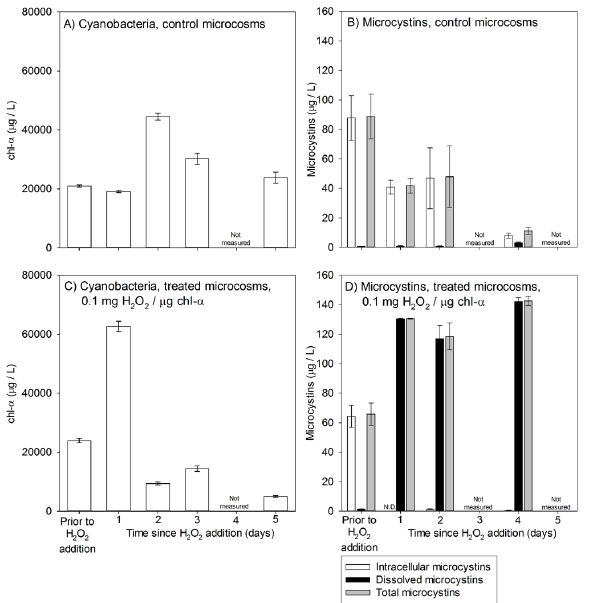
Fig. 1. Results from the first laboratory trial. (A) and (B) demon- strate cyanobacteria and microcystins dynamics in the control mi- crocosms, whilst (C) and (D) demonstrate their behaviour in the treated microcosms. All microcystins concentrations are expressed as microcystin-LR equivalents. Error bars represent standard errors where N =